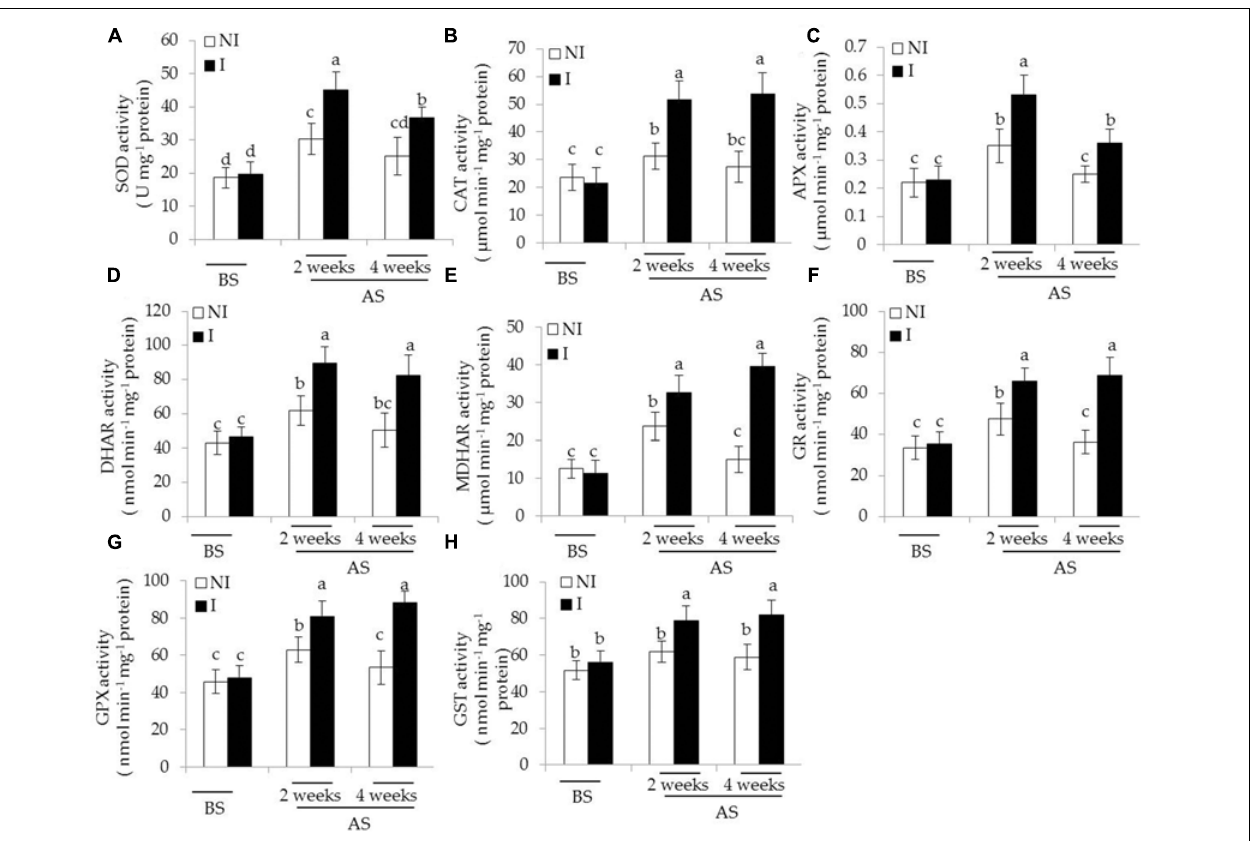
FIGURE 5 | Effects of B. licheniformis SA03 on antioxidant enzymatic activities including (A) SOD, (B) CAT, (C) APX, (D) DHAR, (E) MDHAR, (F) GR, (G) GPX, and (H) GST in Chrysanthemum plants before (BS) or after (AS) saline–alkaline treatment. Treatments and statistical analysis were as described in Figure 2 .